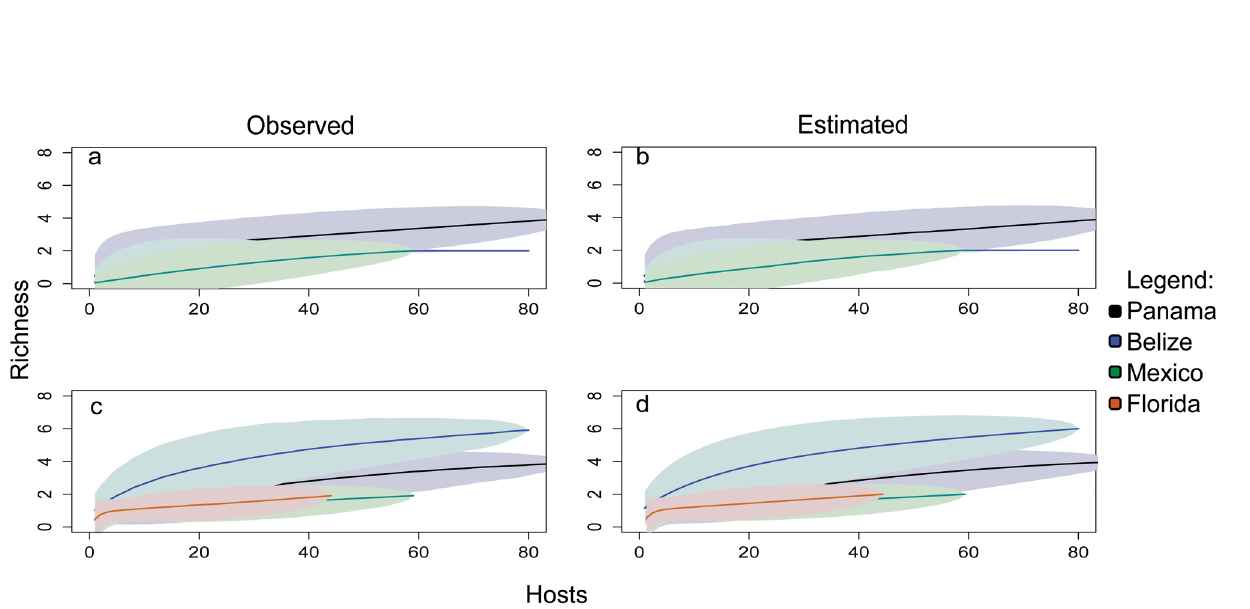
Fig 4. Parasite species accumulation curve for sites grouped by region. Accumulation curves for ectoparasites based on observed richness and estimated richness are shown in (A) and (B), respectively, and for endoparasites in (C) and (D). Each color represents a specific region: Panama (black), Belize (blue), Yucatan (green), Florida (orange). No curve was plotted for Florida in (a) because only one ectoparasite taxon infected P . volitans collected at those sites.